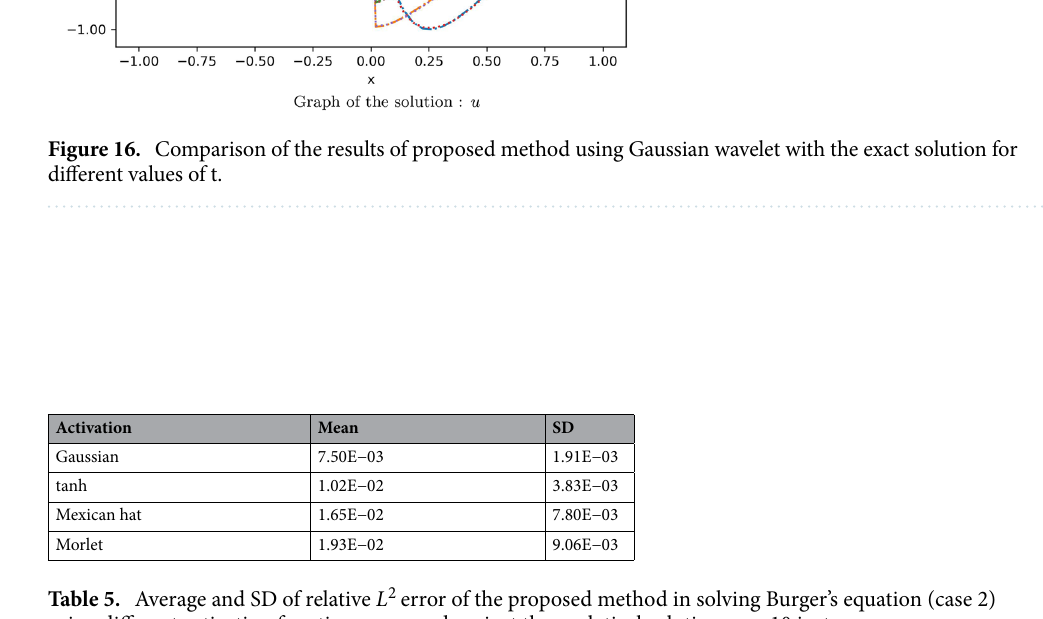
Table 5. Average and SD of relative L 2 error of the proposed method in solving Burger’s equation (case 2) using different activation function compared against the analytical solution over 10